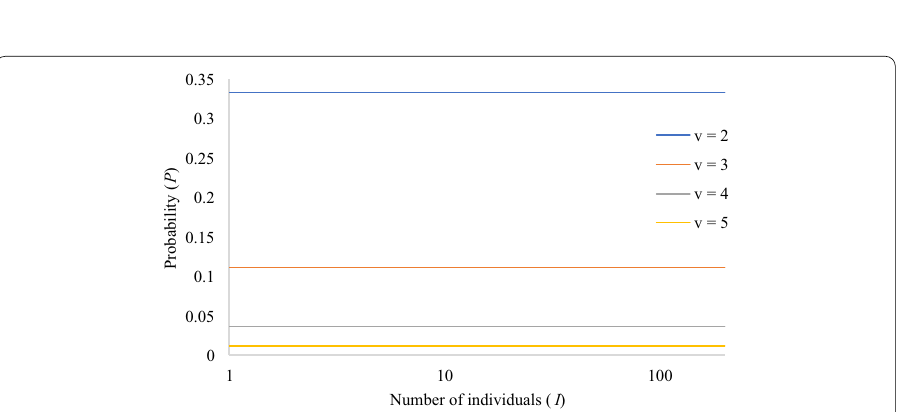
Fig. 3 Given s 3, the probability of grouping interacting features is stable with respect to the increasing = number of individuals I for v 2, 3, 4, 5 interacting features irrespective of the number of =